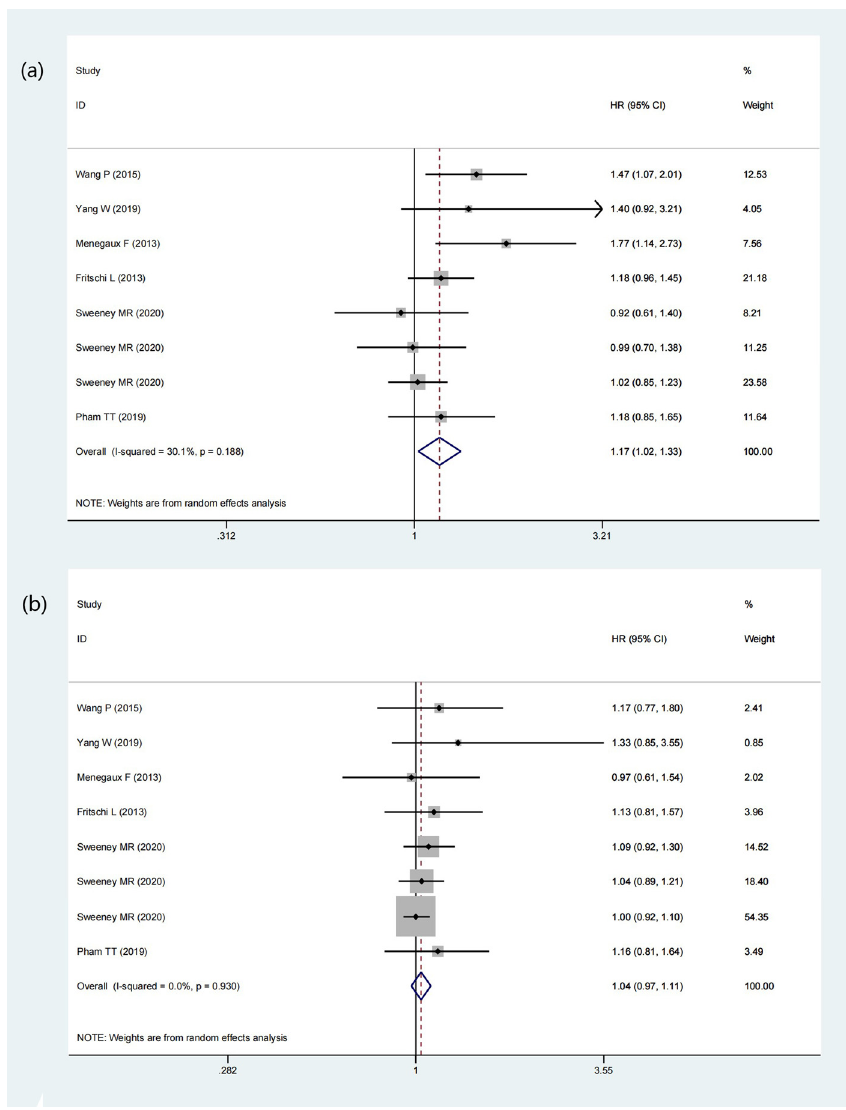
Figure 4: Forest plot describing the association between menopausal status at start of night shift work and risk of BC. ( a ) Night shift work started before menopause. ( b ) Night shift work started after